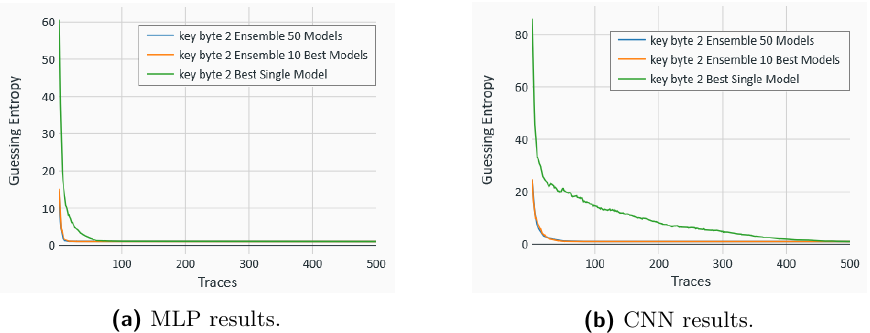
Figure 12: Guessing entropy for ASCAD for the identity leakage model.